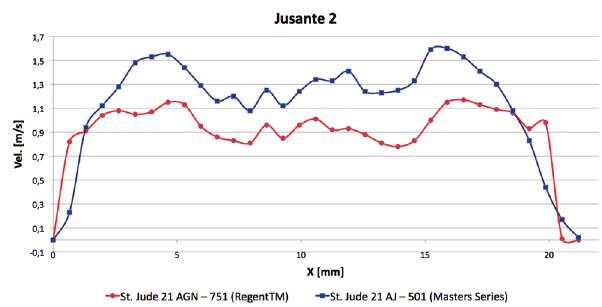
Fig. 7 - Velocity profiles at 20 mm downstream of the valves